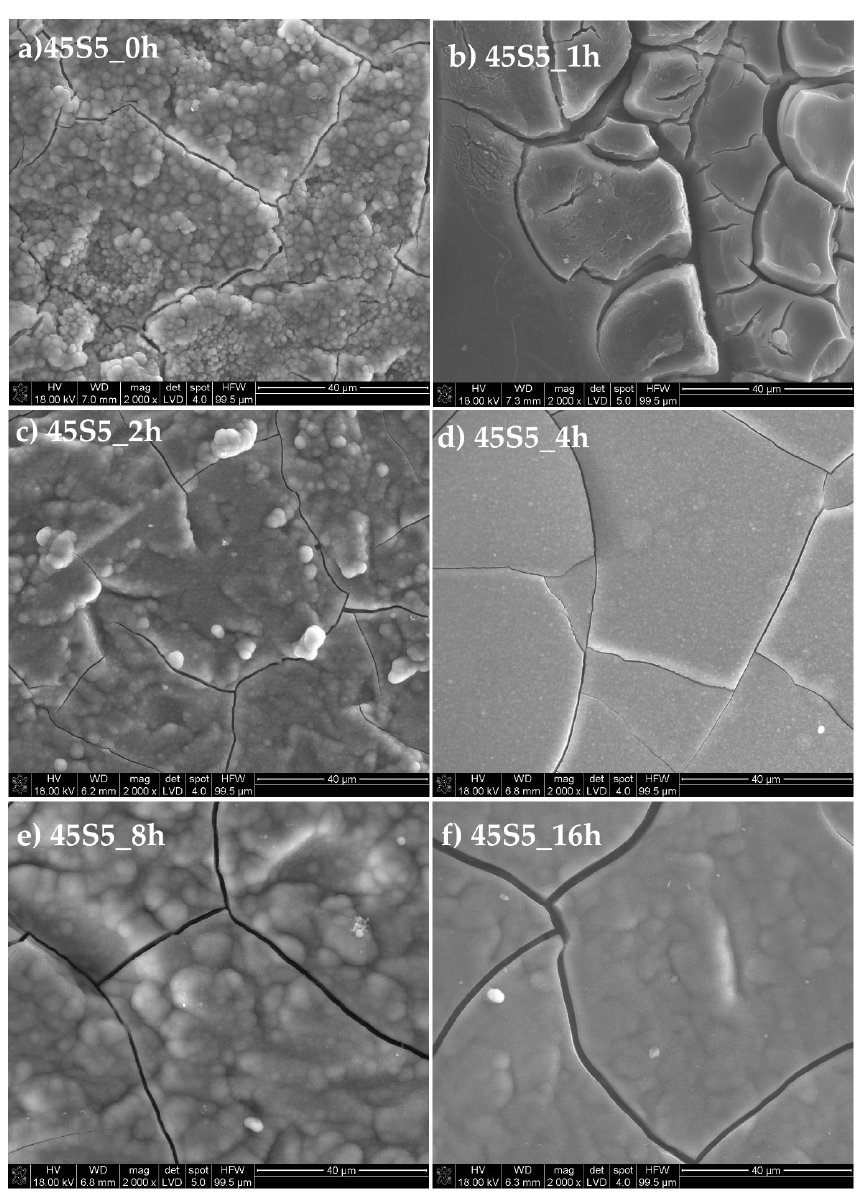
Figure 11. SEM micrographs of 45S5 annealed at 620°C for ( a ) 0 h, ( b ) 1 h, ( c ) 2 h, ( d ) 4 h, ( e ) 8 h, and ( f ) 16 h. Accelerating voltage—18kV.